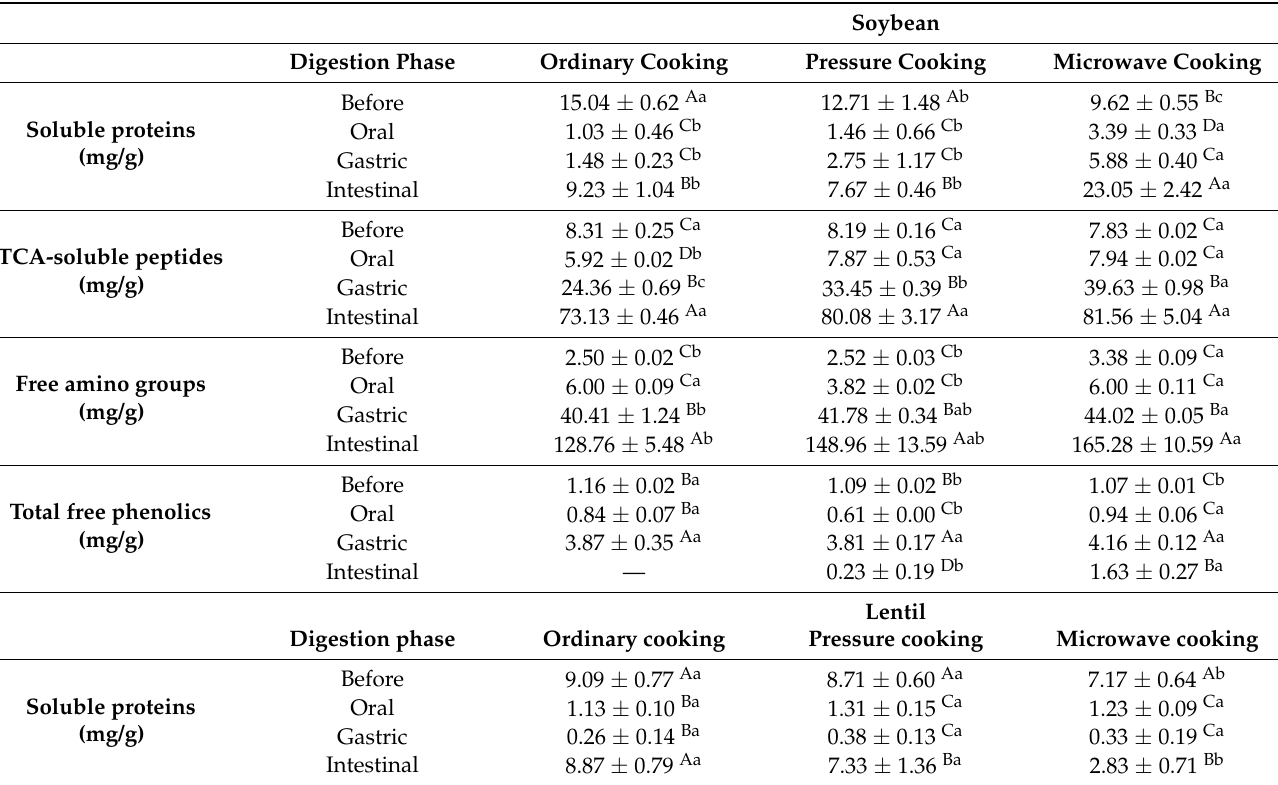
Table 3. Effect of the cooking method on soluble proteins, peptides, free amino groups and total free phenolics contents of legume samples from soybean, lentil and